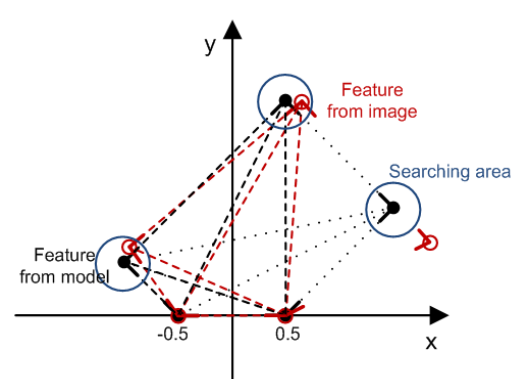
Figure 5. Context features to be used for calculating score